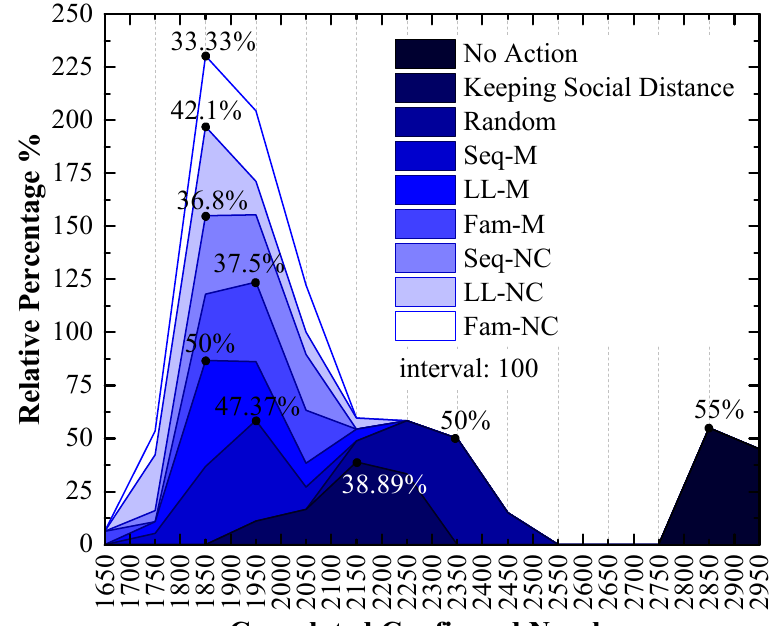
Figure 10. Relative frequency of cumulated confirmed numbers using different strategies in the 2nd scenario. The x-values of the peak values express the cumulative confirmed number with the highest probability.